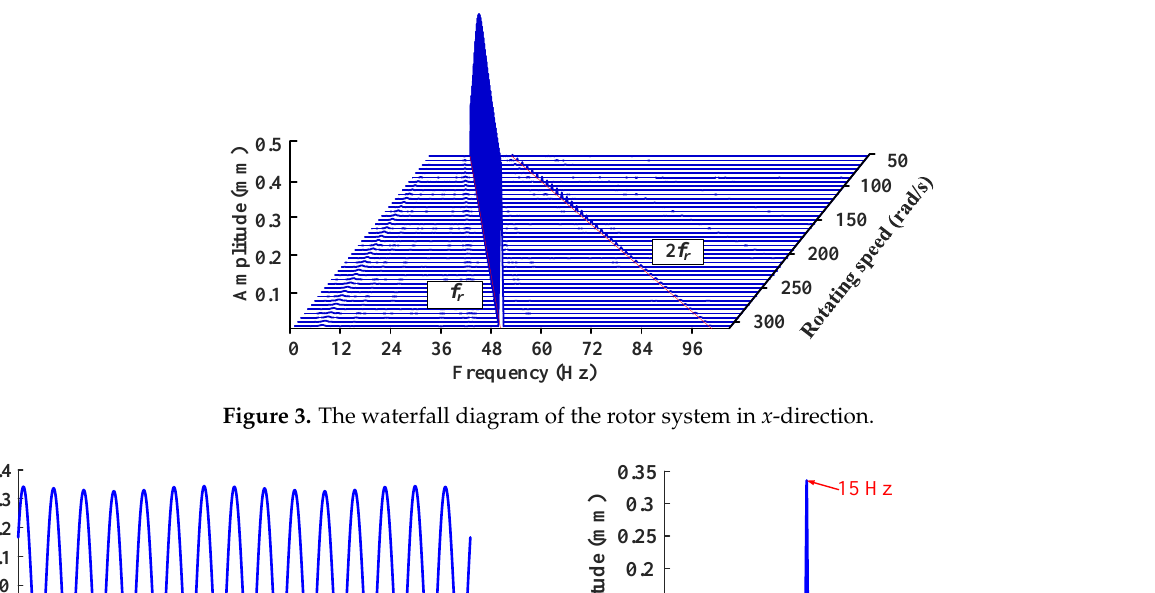
Figure 4. Response of the disk in x -direction ( ω = 94.2 rad/s): ( a ) time domain; ( b ) frequency domain.